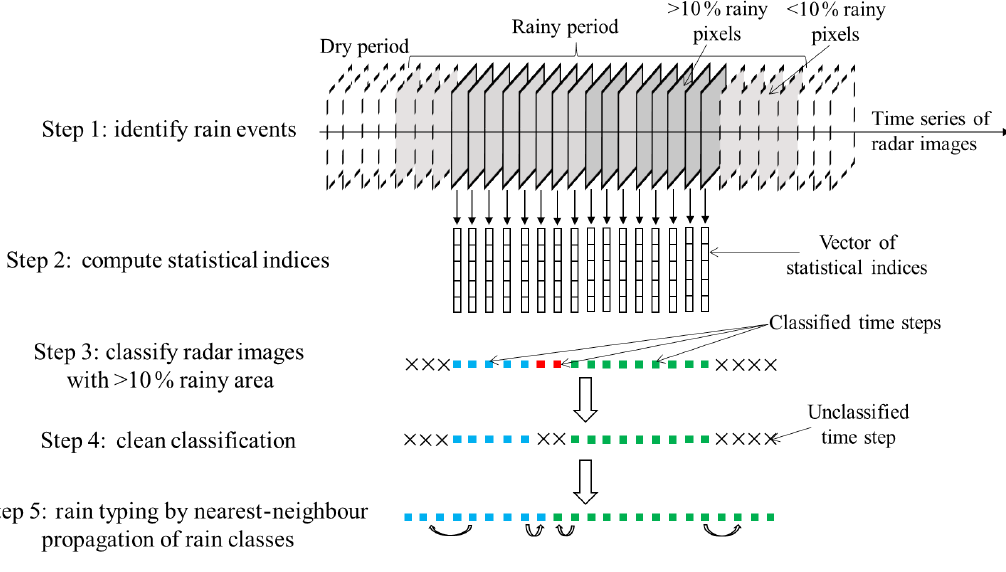
Figure 3. Rain typing